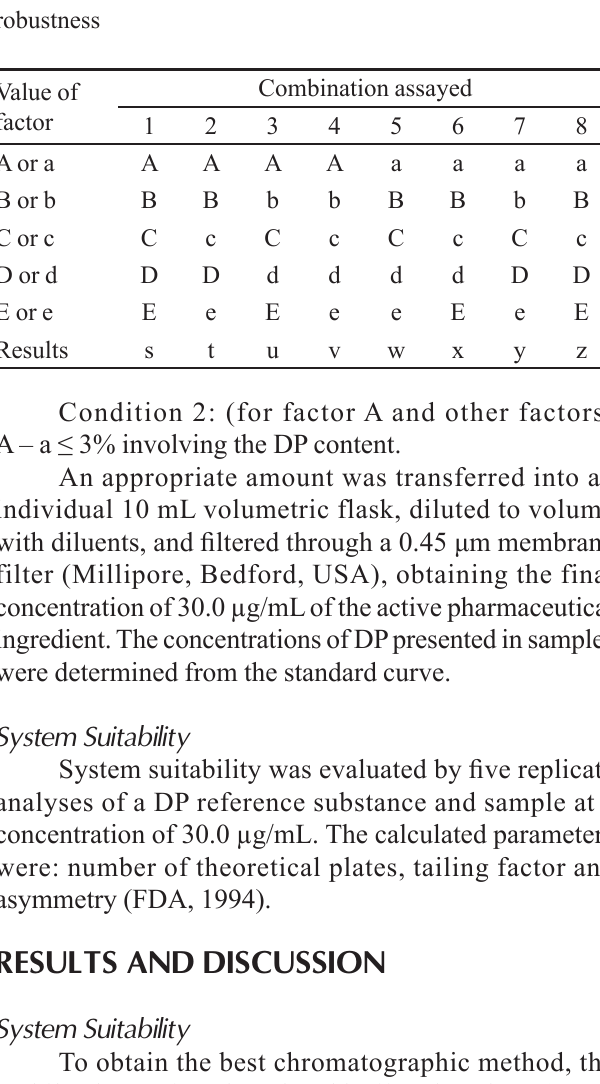
TABLE II - Matrix of factors for the determination of